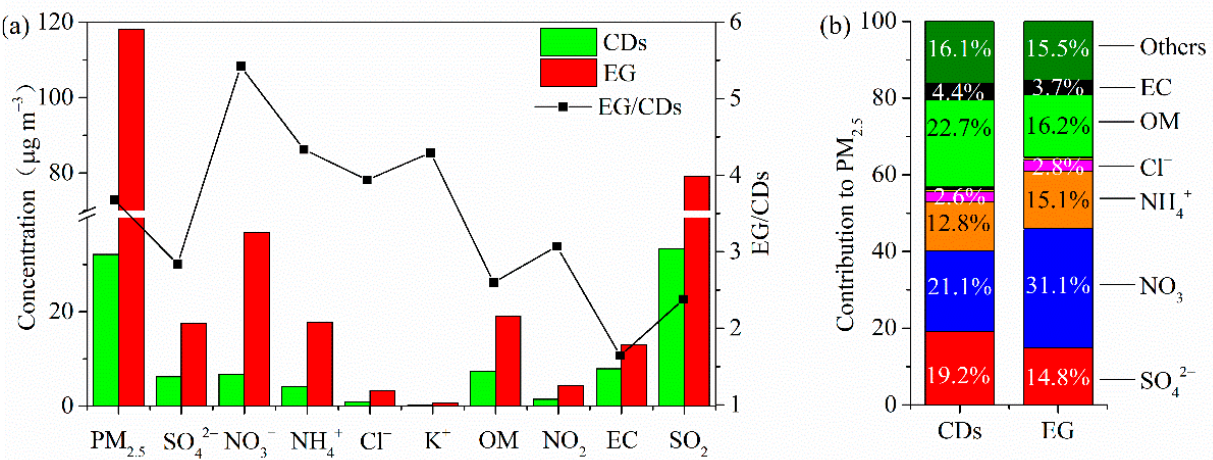
Figure 3. Concentrations of PM 2.5 , ions, carbonaceous compounds, and gas precursors ( a ); and contributions of chemical PM 2.5 components ( b ) during CDs and EG.